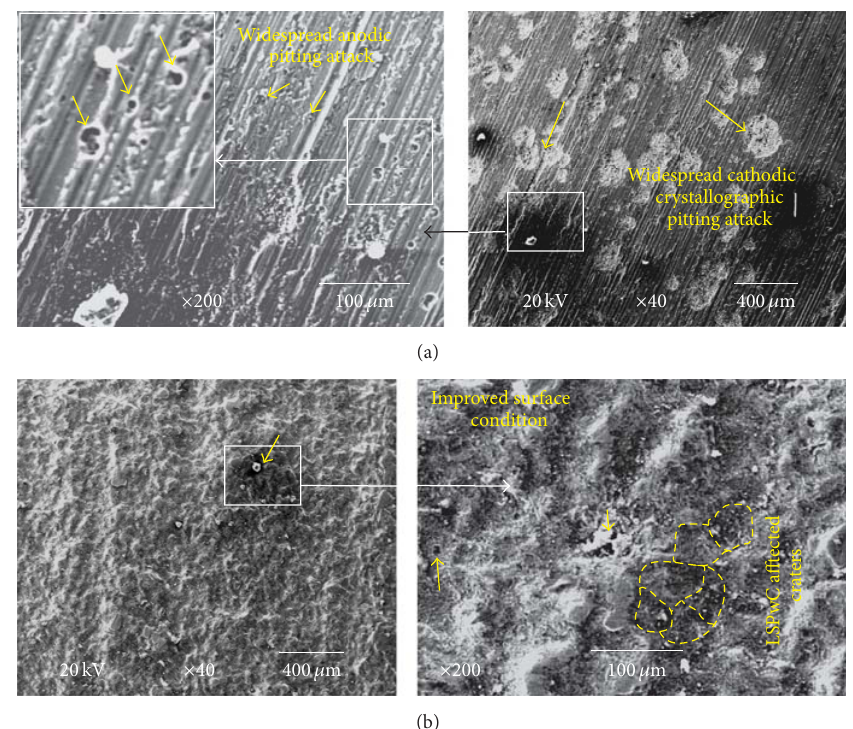
Figure 8: SEM/SEI images of the surface condition of the untreated and LSPwC treated specimen surfaces. (a) Untreated and (b) LSPwC treated specimen.